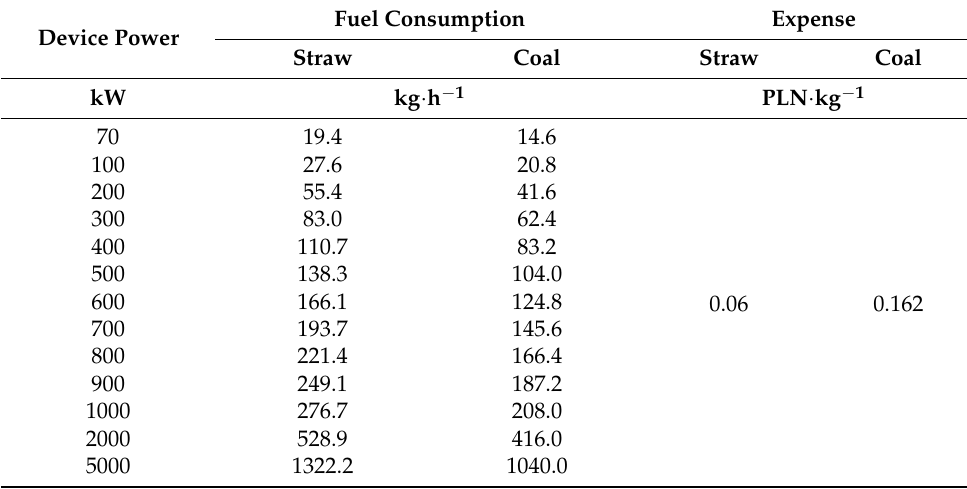
Table 5. A summary of the costs of burning straw and coal—KAPE calculations [44]. Device